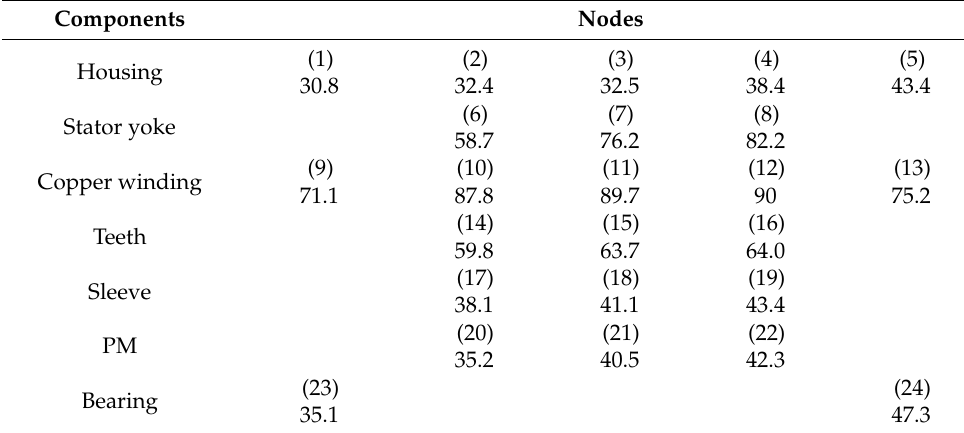
Table 7. Initial A4 model maximum temperature